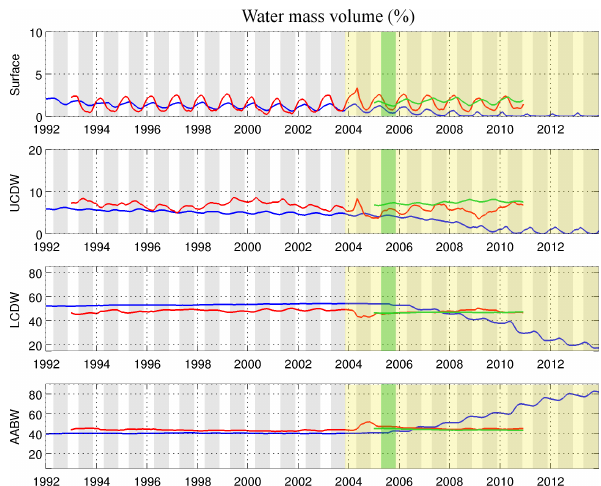
Figure 4. Percentage of the Indian Ocean sector occupied by the water mass, in volume. From top to bottom, the charts show the vol- umes for unclassified surface waters, Upper Circumpolar Deep Wa- ter (UCDW), Lower Circumpolar Deep Water (LCDW) and Antarc- tic Bottom Water (AABW). The red, blue and green lines are for the UR025.4, ECCO2 and SoSE reanalyses, respectively. Green and yellow shadings highlight the period in which the polynyas are open in SoSE and ECCO2,